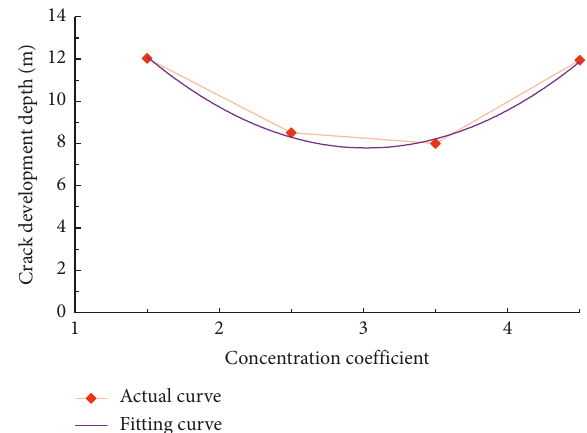
Figure 6: Curve of the accommodating pressure concentration and crack development.